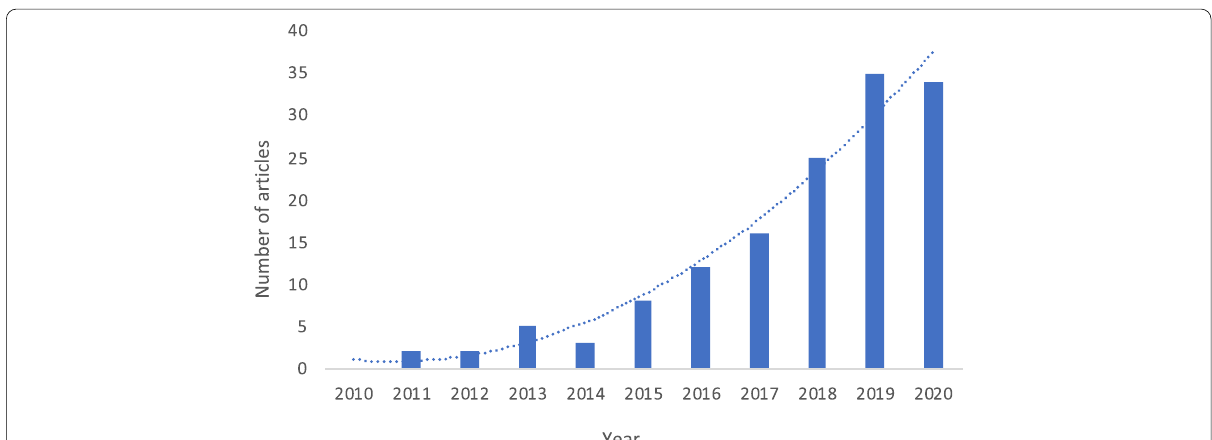
Fig. 1 Number of peer-reviewed articles on microplastic particles in the Mediterranean Sea basin published per year (2010–2020 data only). The line depicts the relationship between the number of articles and year. This figure only includes articles that met the inclusion criteria of this